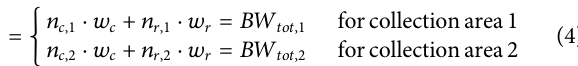
Frontiers in Chemical Engineering |